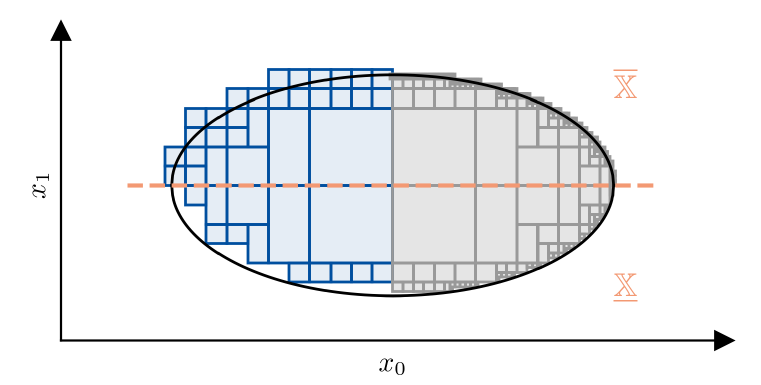
Figure 1. Example of an inner coverage (bottom) and outer coverage (top) of a set by subpavings with low resolution (blue) and high resolution (gray).